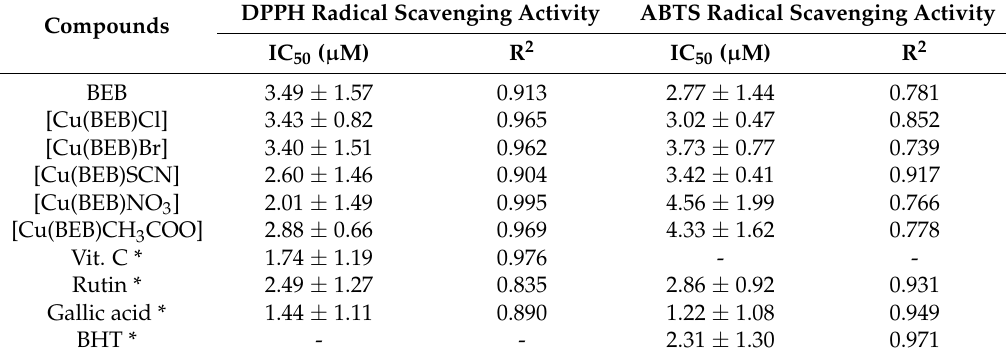
Activities of as-synthesized compounds and standard agents against DPPH* and ABTS*